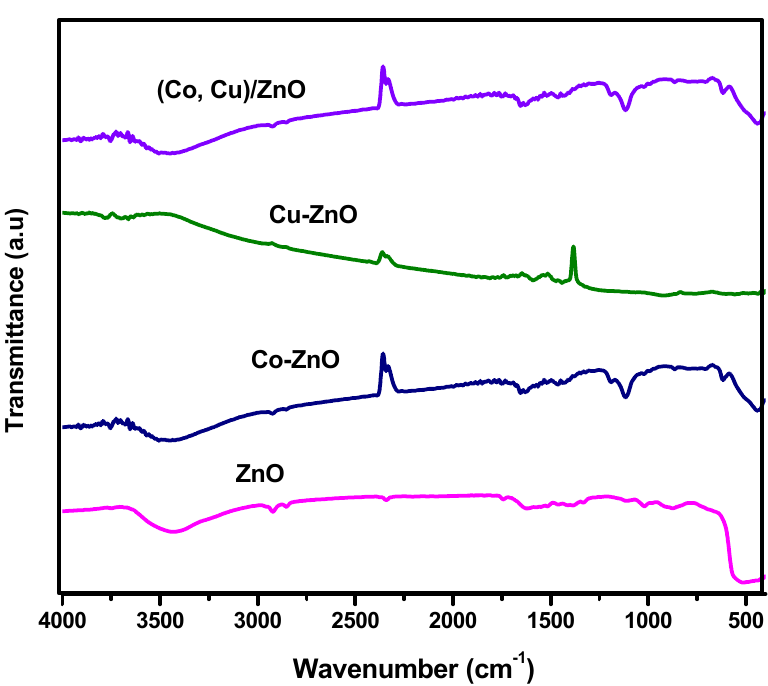
Fig. 4. FTIR spectrum of ZnO, Cu-ZnO, Co-ZnO and (Co,